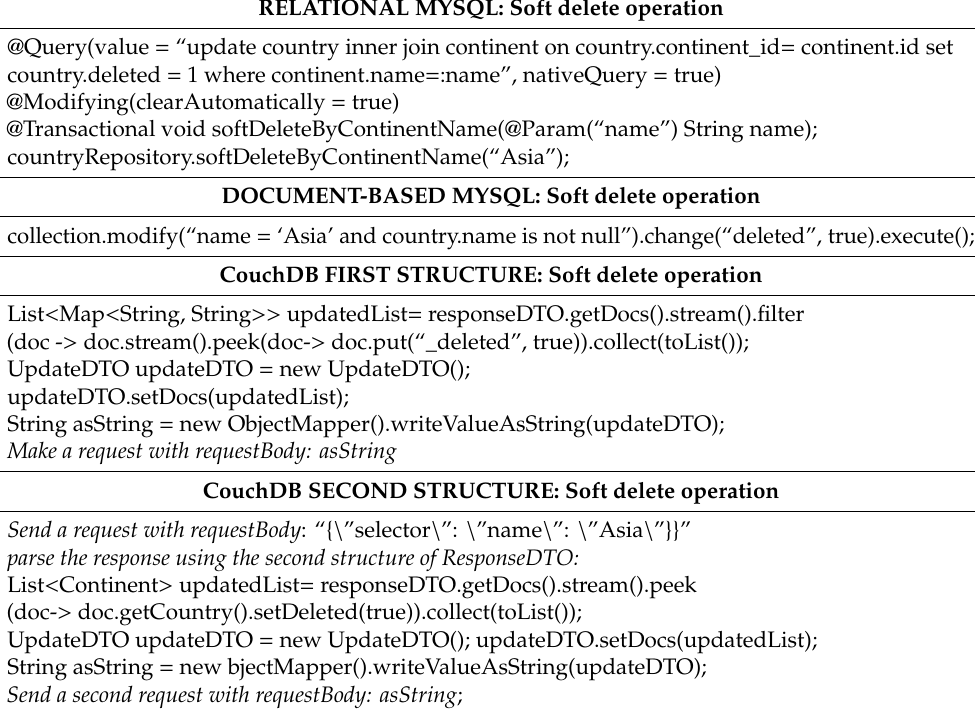
Table 9. Soft delete